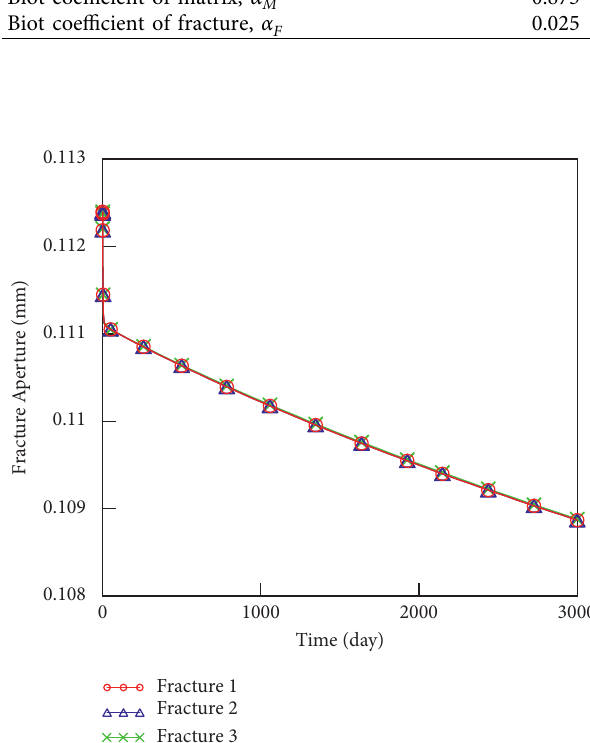
Figure 11: Fracture aperture histories for isotropic case.